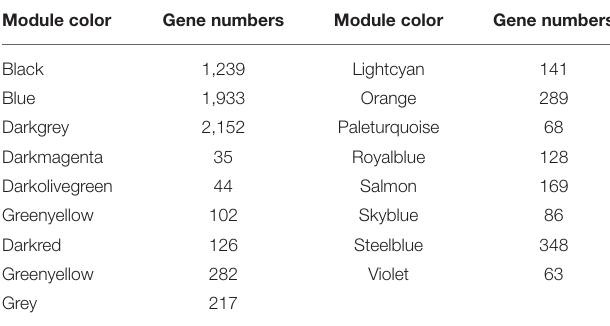
TABLE 1 | Gene number in 17